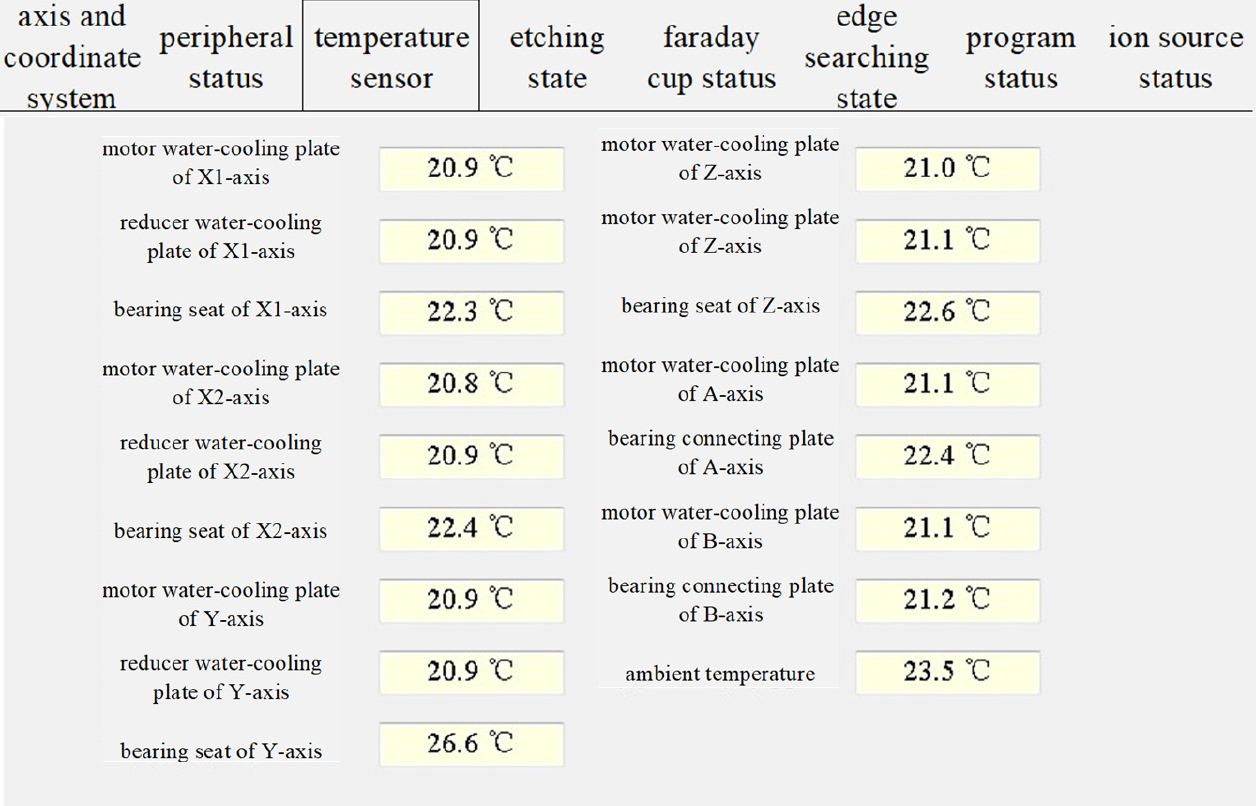
Figure 17. Upper computer interface during the whole machine test.